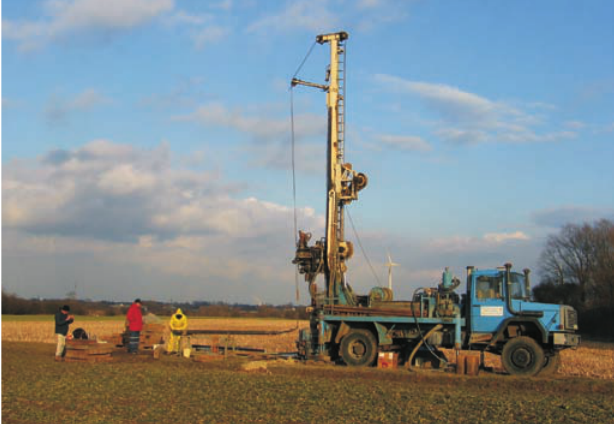
Figure 2. Coring at the Wunstorf drill site in March